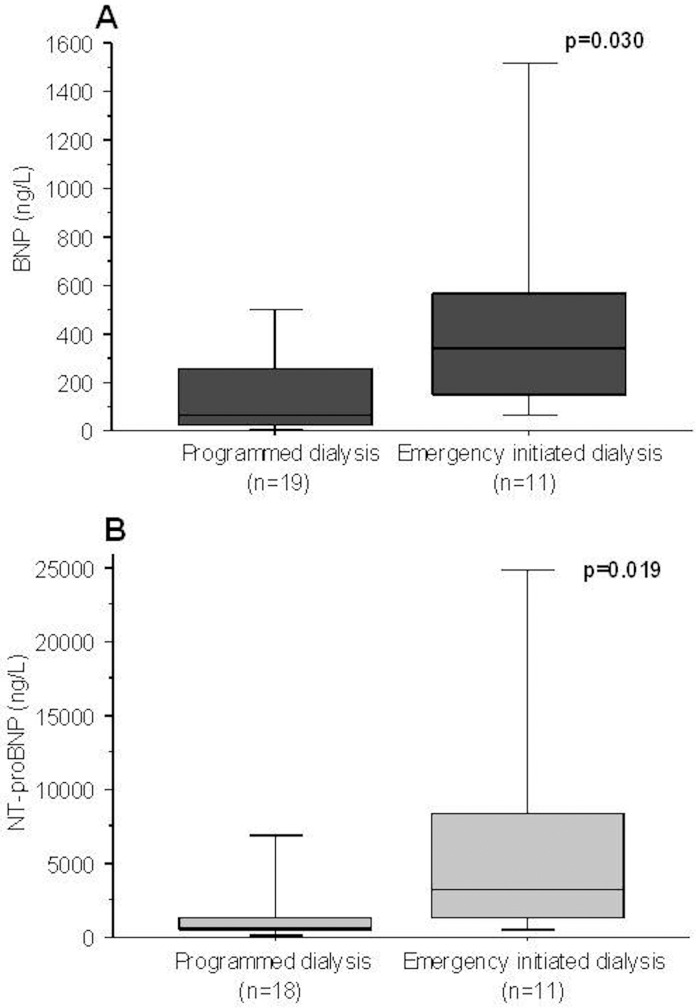
Baseline plasma natriuretic peptide concentrations for BNP (A) and NT-proBNP (B), according to the urgent or programmed dialysis initiation.Thirty patients had initiated dialysis within 5 years follow-up. Nineteen dialysis sessions were programmed and 11 were initiated urgently. Differences between the groups were analyzed using the Mann-Whitney U test.